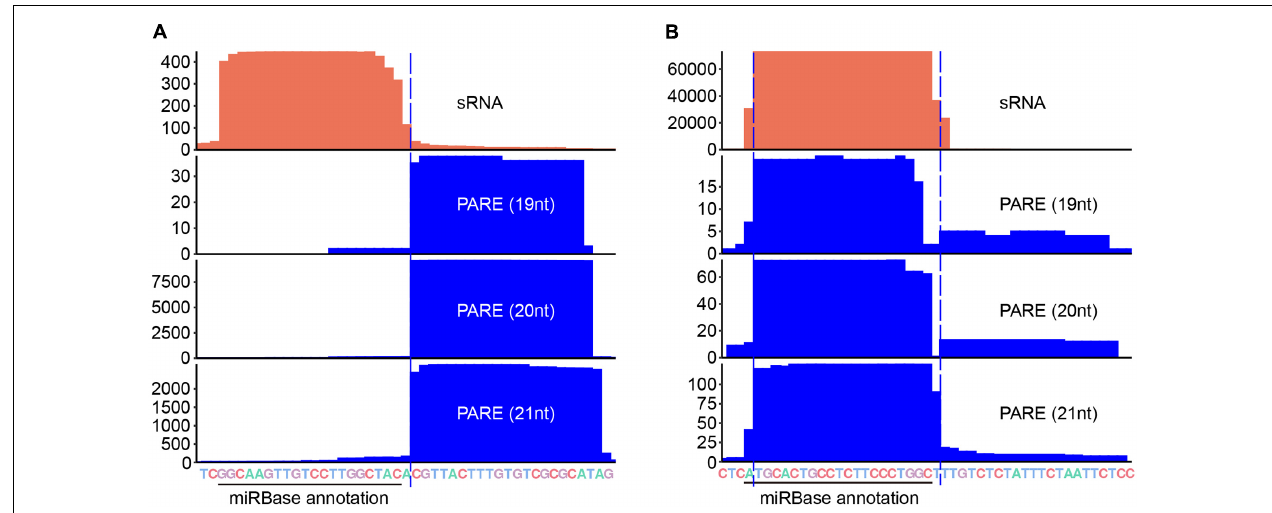
FIGURE 6 | Parallel Amplification of RNA Ends (PARE) corrects miR-3p annotations. Coverage of sRNA (orange) and PARE (blue) read alignments around ath-miR169a-3p (A) and gma-miR408c-3p (B) . Black solid line, miRBase annotated miR-3p border; blue dashed line, PARE corrected miR-3p border. Merged sRNA datasets ( Supplementary Table 1 ) were used for sRNA analysis and datasets under the accession numbers SRR1171802 (for ath-miR169a-3p) and SRR1451679 (for gma-miR408c-3p) were used for PARE analysis.